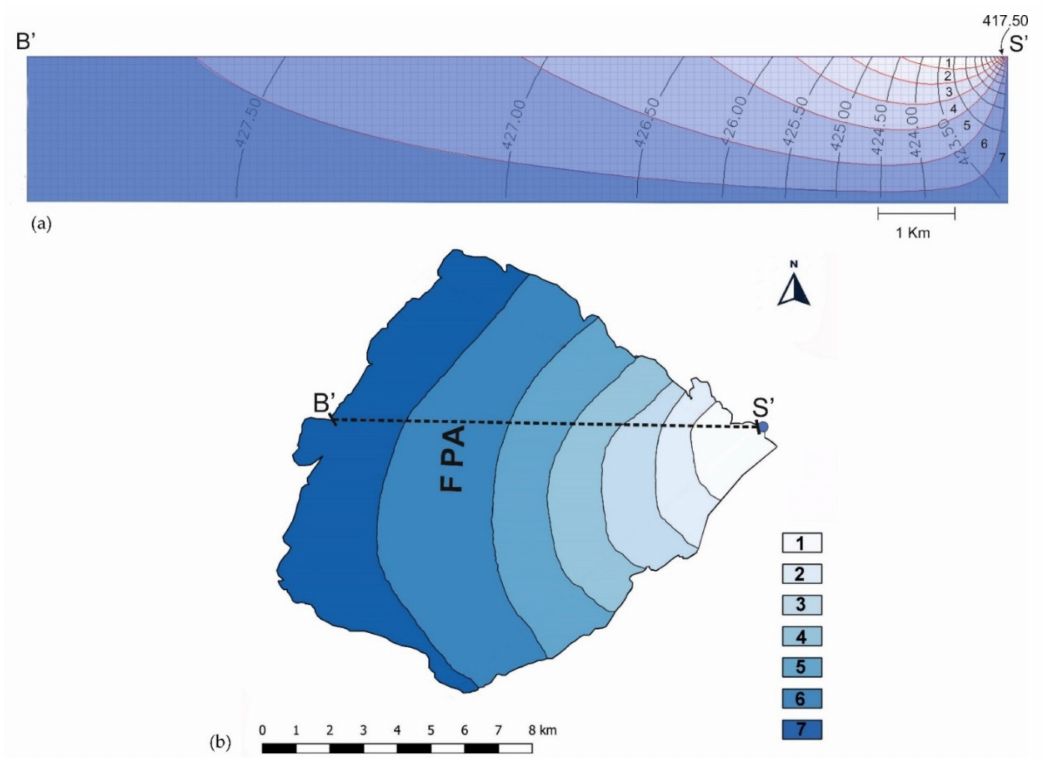
Figure 13. ( a ) 2D vertical groundwater model along the cross-section trace B’S’; ( b ) Caposele spring catchment zoning in flow pipe areas (FPA) for a model thickness of 2000 m; each flow area is marked by di ff erent colors and the related item.